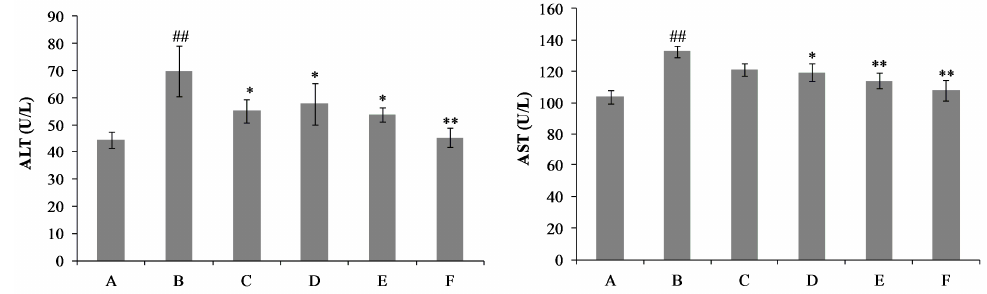
Figure 2. Effects of nicotiflorin on serum alanine aminotransferase (ALT) and aspartate aminotransferase (AST) in Con A- intoxicated mice. (A) Control group; (B) Con A-treated group; (C) Con A and biphenyl dicarboxylate (DDB, 150 mg/kg bw)-treated group; (D) Con A and nicotiflorin (25 mg/kg bw)-treated group; (E) Con A and nicotiflorin (50 mg/kg bw)-treated group; and (F) Con A and nicotiflorin (100 mg/kg bw)-treated group. Values are mean ± S.E.M., n = 10. ## p < 0.01 compared with control group; * p < 0.05, ** p < 0.01 compared with Con A group. Table 2. Effects of nicotiflorin on the pathological grading of Con A-intoxicated mice. Group Con A